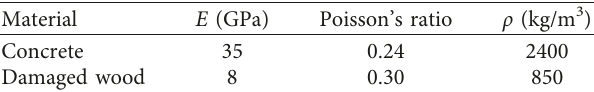
Table 2: Parameters of the two-pile model.